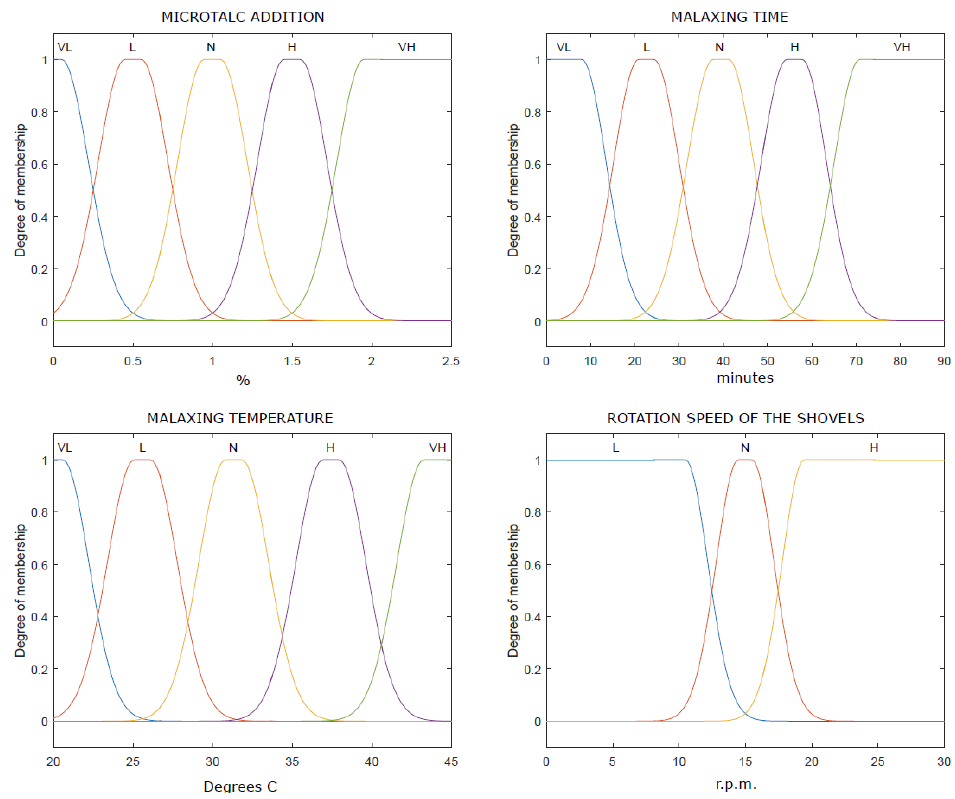
Figure 9. Output fuzzy membership functions.